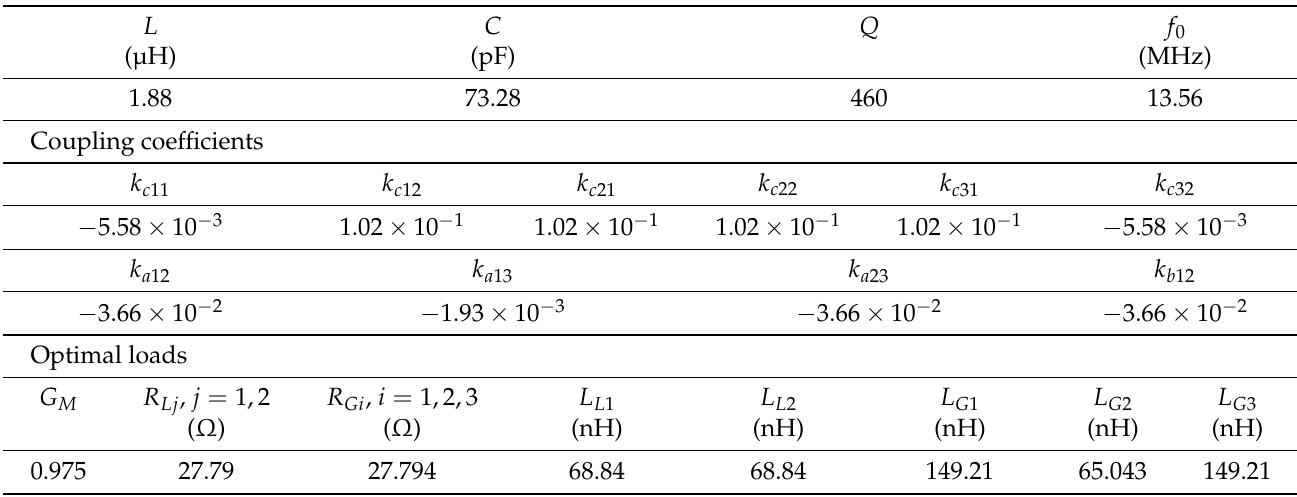
Table 1. Parameters of the equivalent circuit and optimal loads for Case 1. C L , i and C G , j (or L L , i and L G , j ) are the optimal compensating capacitors (or inductors) to be used for the receiver i and the transmitter j